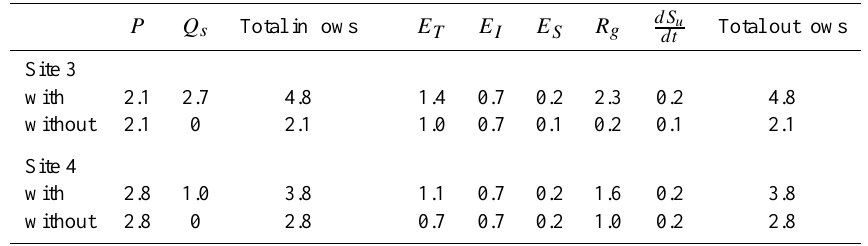
Table 1. Water partitioning “with” and “without” Sis (mmd −